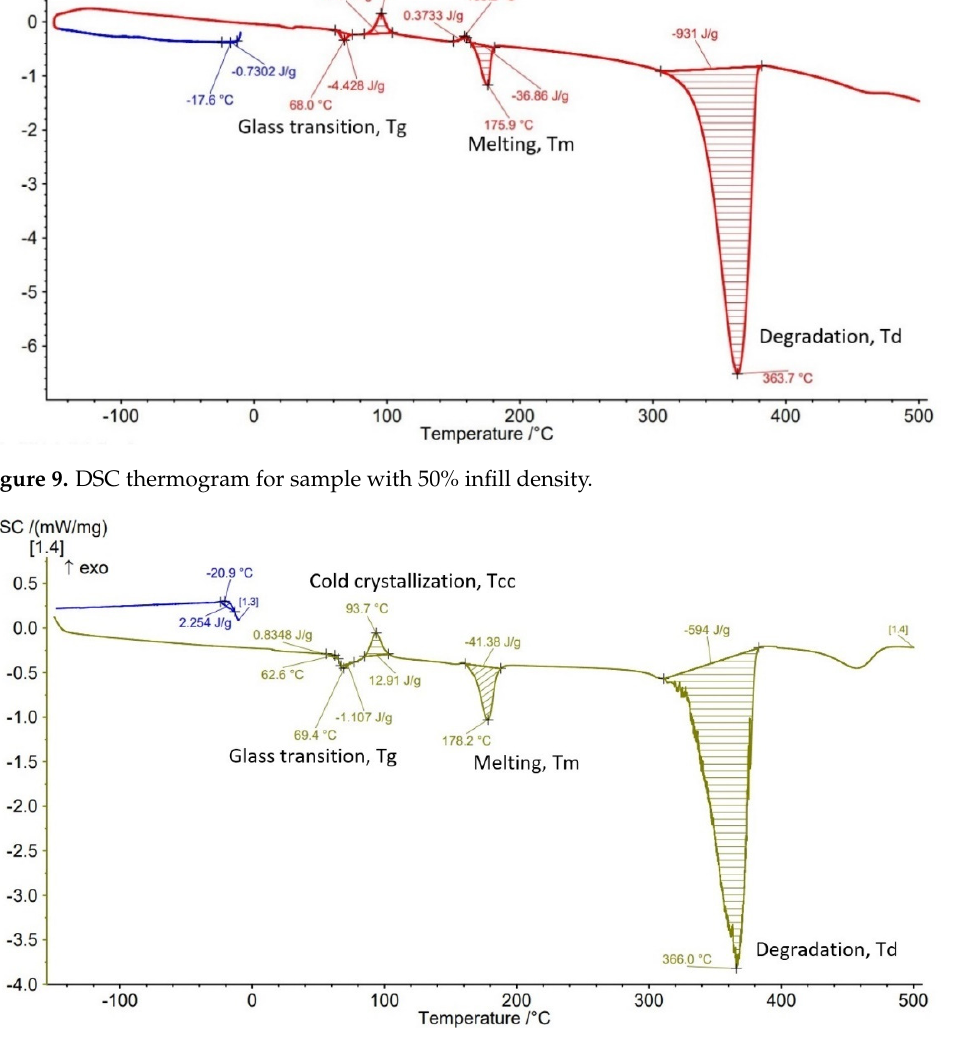
Figure 10. DSC curves related to sample with 75% infill density.